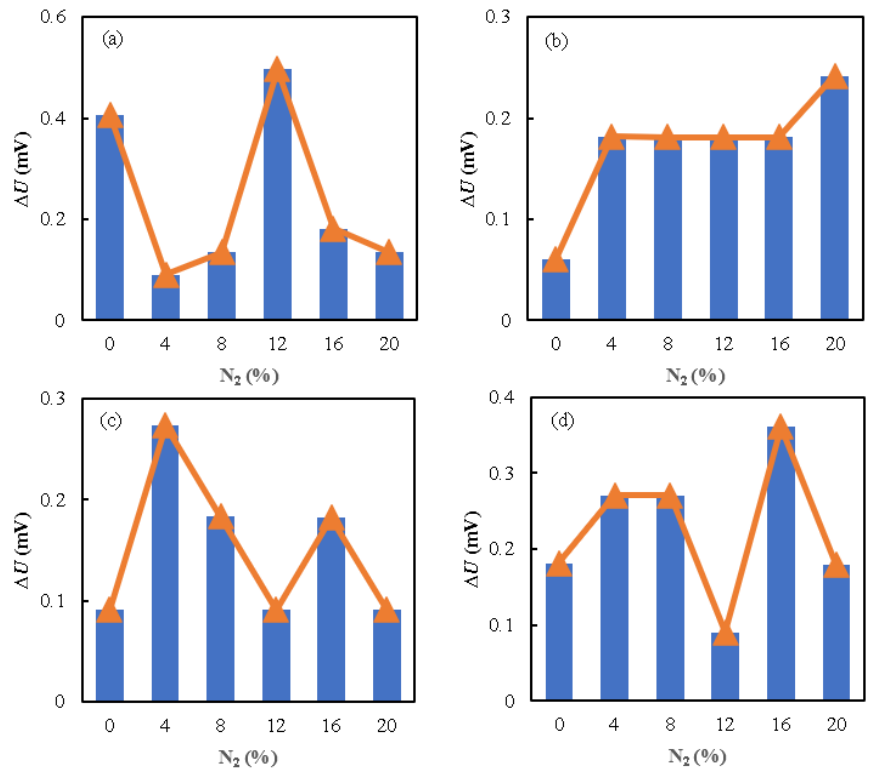
Figure 5. Error analysis with different nitrogen concentrations at different current densities: ( a ) 0.2 A ∙ cm − 2 ; ( b ) 0.6 A ∙ cm − 2 ; ( c ) 1.0 A ∙ cm − 2 ; ( d ) 1.4 A ∙ cm − 2 .